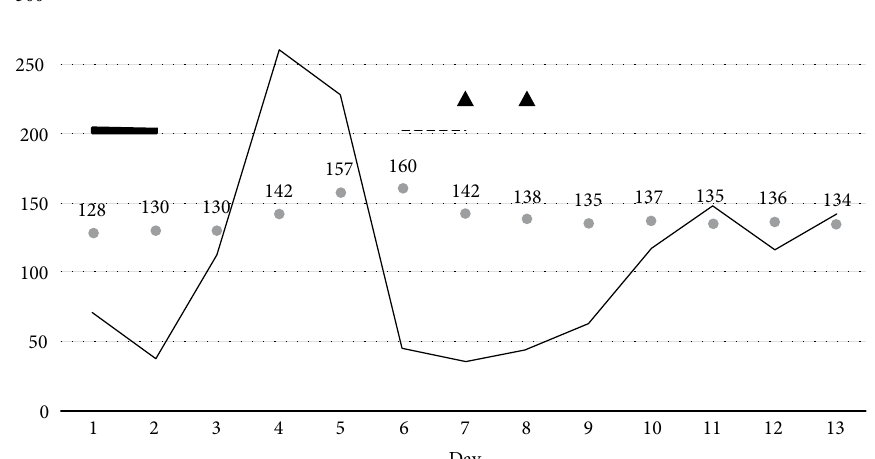
Figure 1: Overview of serum sodium and urine output trends in relation to therapies. Thin solid line represents average urine output (mL/hr), numbered bullet points showing measured serum sodium (mmol/L), thick solid line denoting time of intravenous vasopressin administration, dotted line denoting period of intravenous desmopressin administration, and triangles show intranasal desmopressin administration.